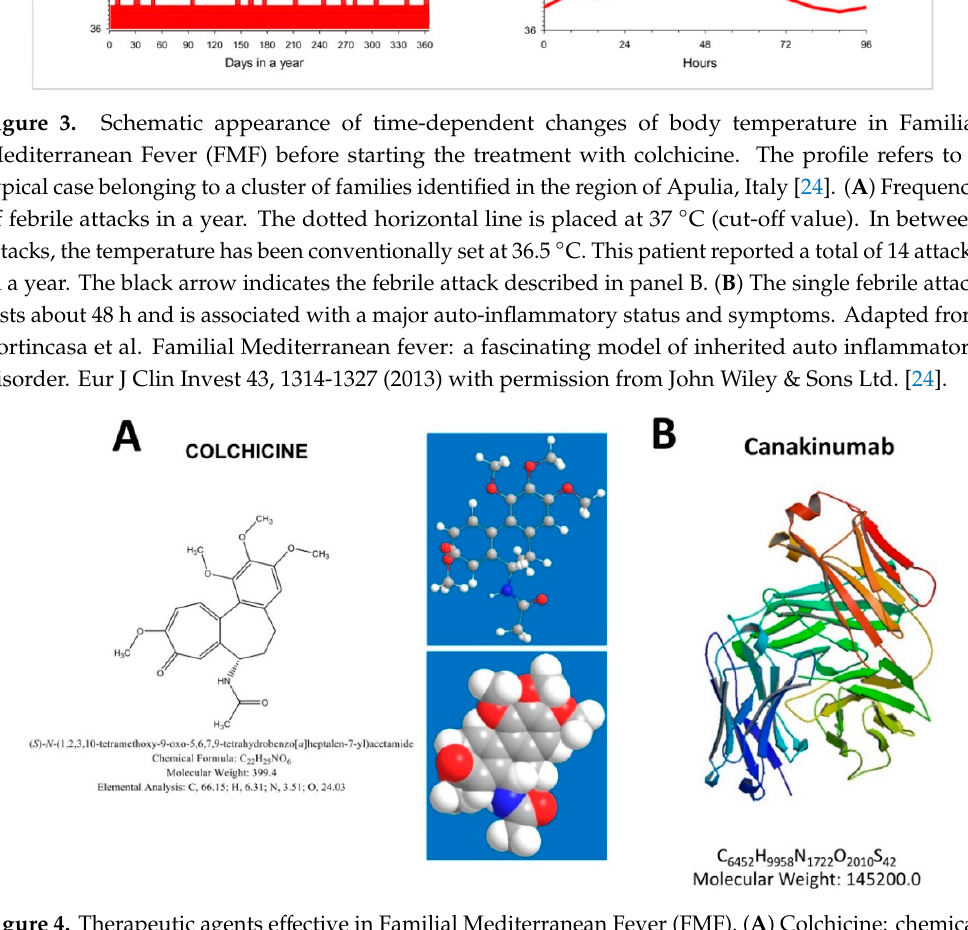
Figure 4. Therapeutic agents effective in Familial Mediterranean Fever (FMF). ( A ) Colchicine: chemical structure, IUPAC names, chemical formula, molecular weight and three-dimensional (3D) structures. ( B ) Canakinumab: 3D structure, chemical formula and molecular weight.